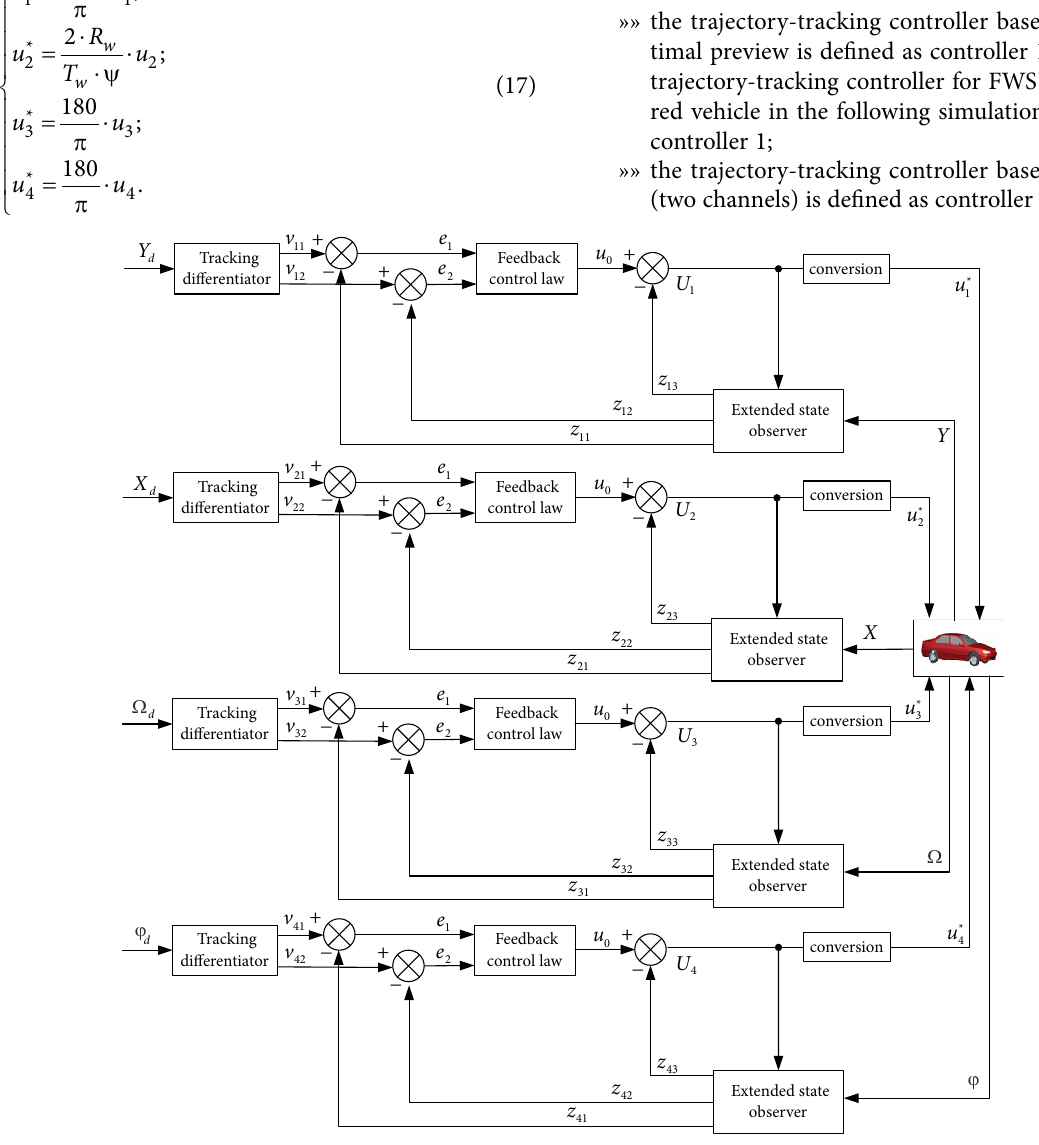
Figure 2. Total control algorithm flow chart of the trajectory-tracking controller (four